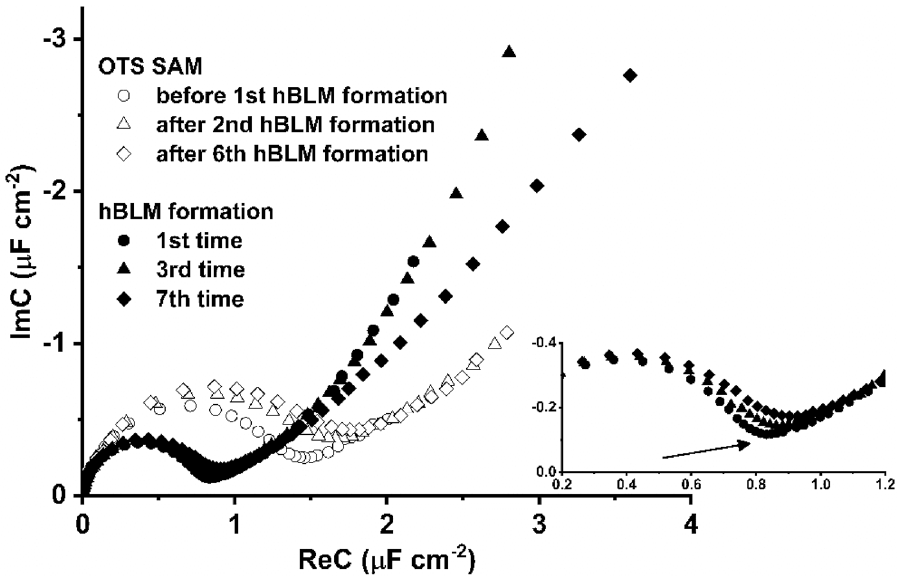
Figure 5. Cole–Cole plots of electrochemical impedance spectroscopy of the OTS SAM regeneration for DOPC:Chol (molar % ratio 6:4) hybrid bilayer formation on the metallurgical aluminum surface. The applied potential for EI measurements: − 0.7 V versus Ag/AgCl/NaCl (sat.) . Inset shows an enlarged part of the complex capacitance plot of the hBLM